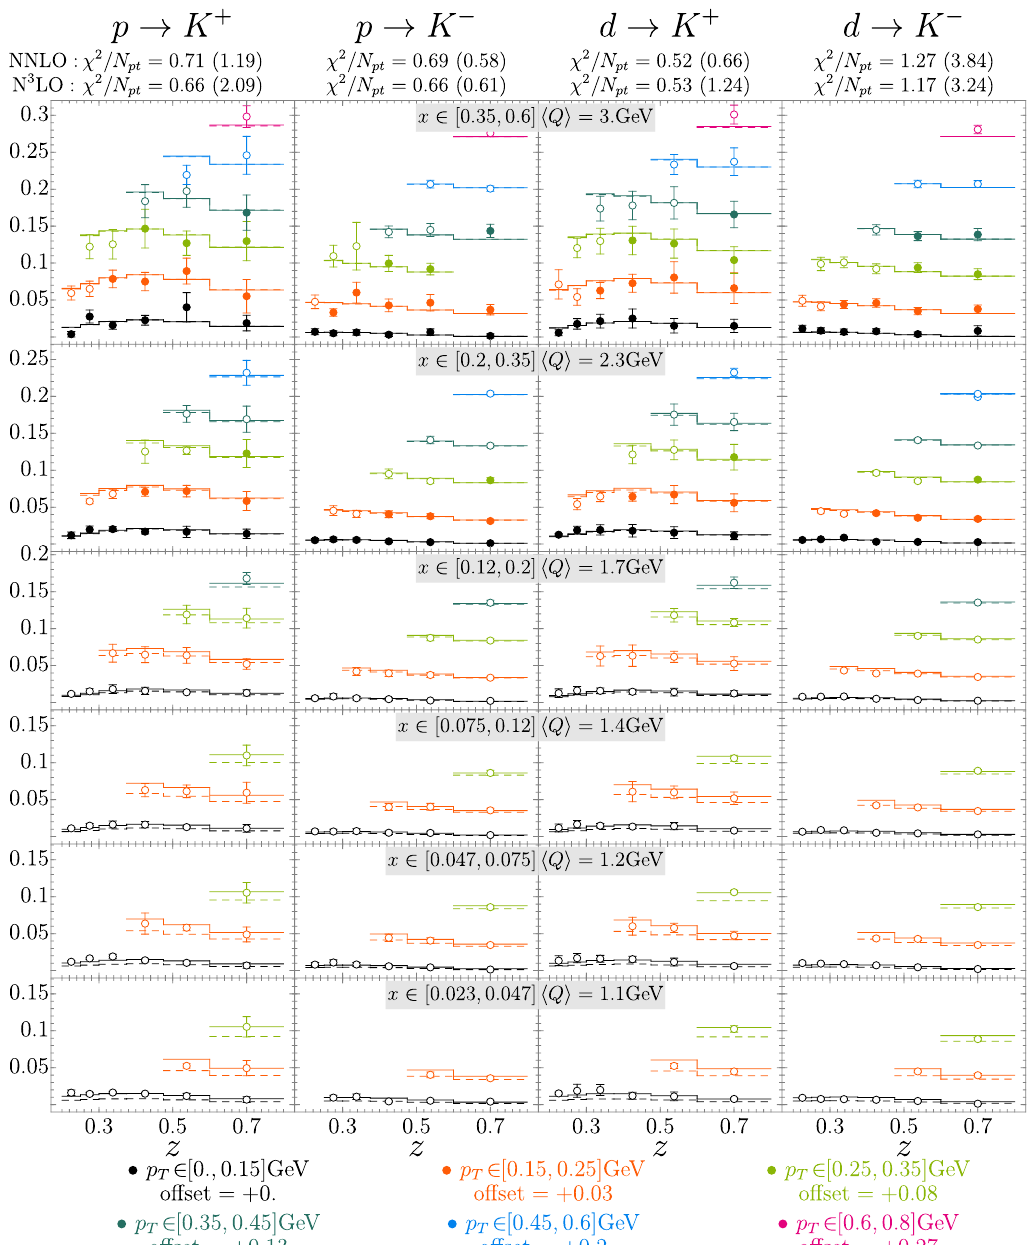
Figure 18 . Unpolarized SIDIS multiplicities (4.4) (multiplied by z 2 ) for production of kaons o(cid:11) proton/deuteron measured by HERMES in di(cid:11)erent bins of x , z and p T . Solid (dashed) lines show the theory prediction at NNLO (N 3 LO). Filled (empty) point were (not) included in the (cid:12)t of NP parameters. On the top of the table the value of (cid:31) 2 =N pt for each channel is presented, the value in brackets being the (cid:31) 2 =N pt for shown set of the data (empty and (cid:12)lled points together). For clarity each p T bin is shifted by an o(cid:11)set indicated in the legend.